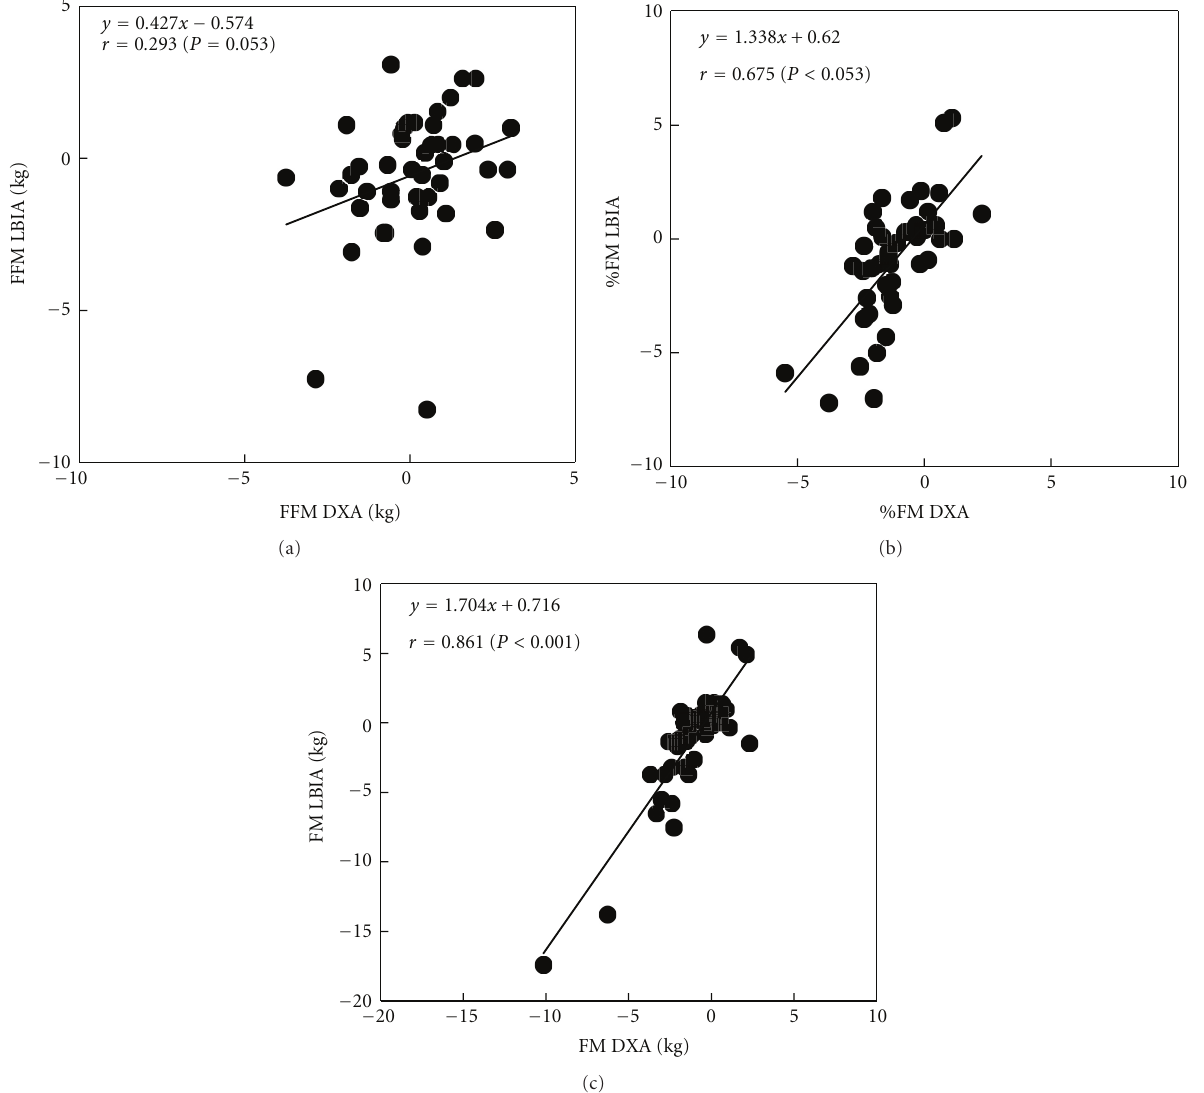
Figure 3: Change in FFM (a), %FM (b), and FM (c) measured by LBIA compared with DXA. DXA: dual X-ray absorptiometry; LBIA: leg-to-leg bioelectrical impedance analysis; FFM: fat free mass; %FM: percentage body fat; FM: fat